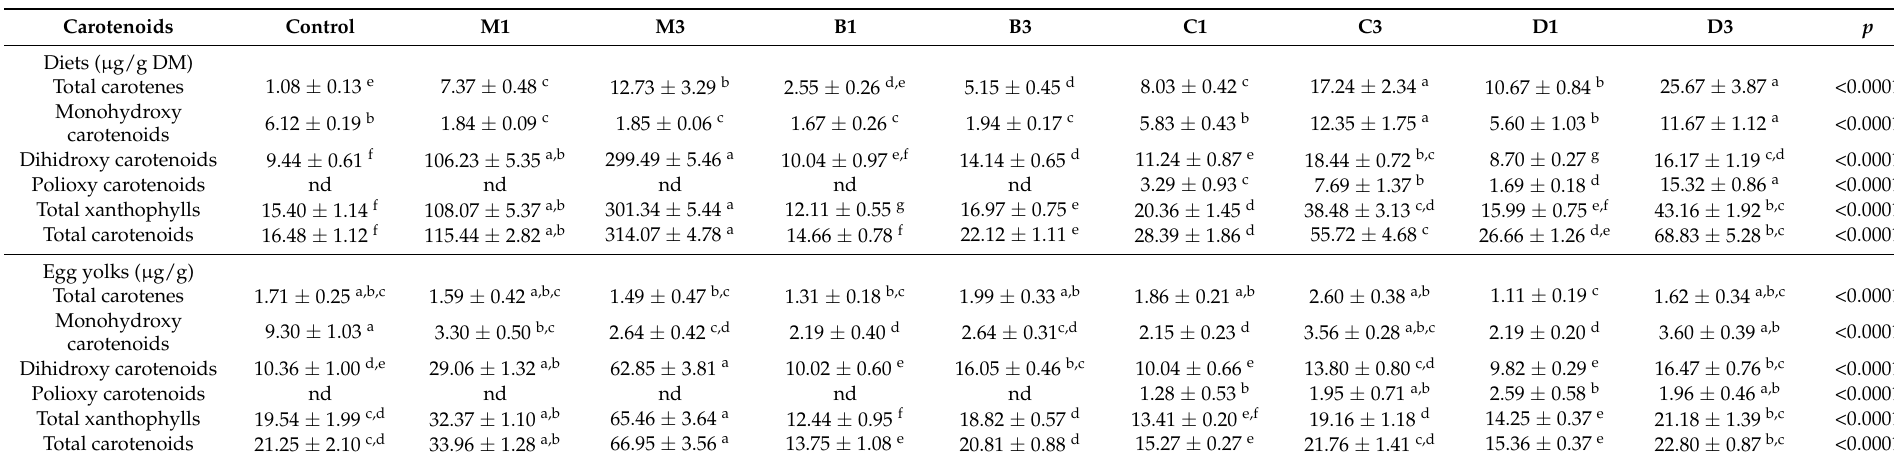
Table 3. Contents of carotenoid compounds (average ± SD) in diets and egg yolks of hens fed diets differentiated in pigment supplementation (B1 and B3—1% and 3% basil herb; C1 and C3—1% and 3% calendula flower; D1 and D3—1% and 3% dandelion flower; and M1 and M3—1% and 3% marigold